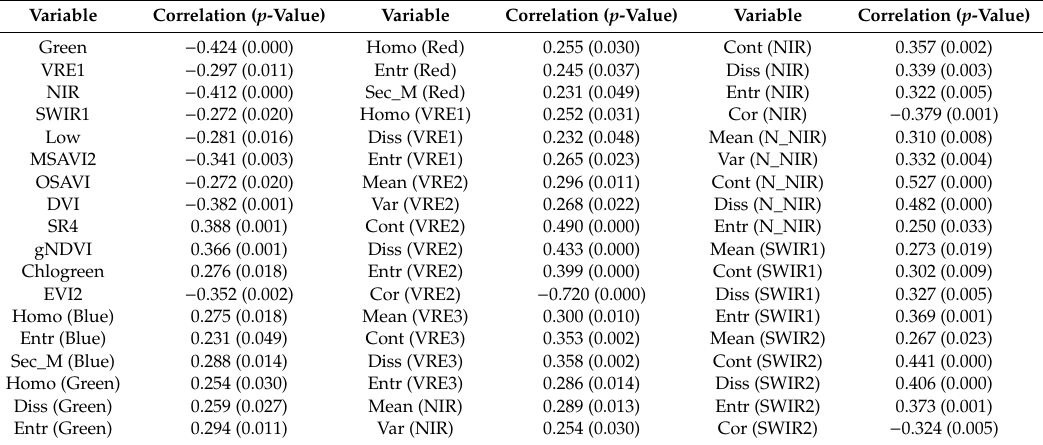
Table 5. Variables significantly correlated with broadleaved forest